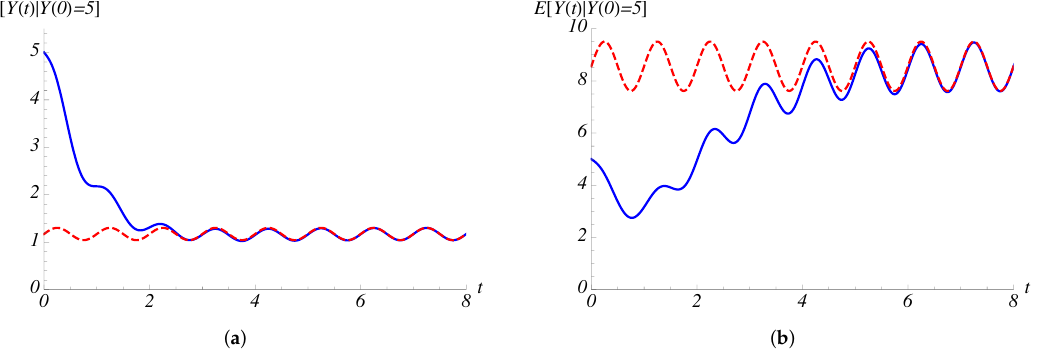
(cid:0) (cid:1) 2 (cid:0) (cid:1) 2 1 − e − 1.2 t ; ( b ) σ 2 ( t ) = 2 1 − e − 1.2 t .